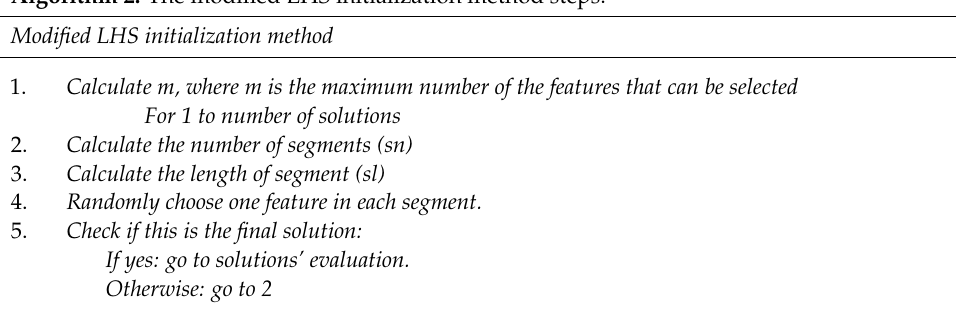
Algorithm 2. The modified LHS initialization method steps.